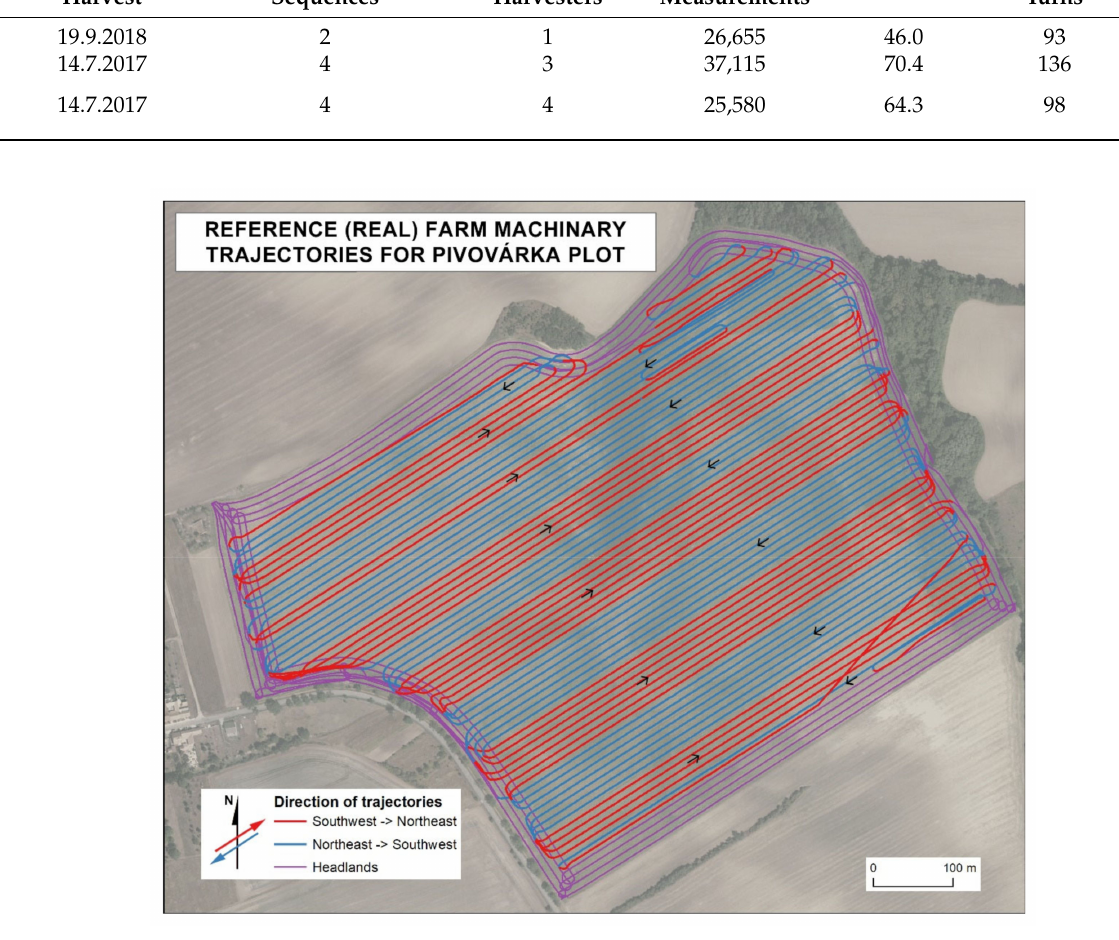
Figure 4. Reference (real) farm machinery trajectories with marked